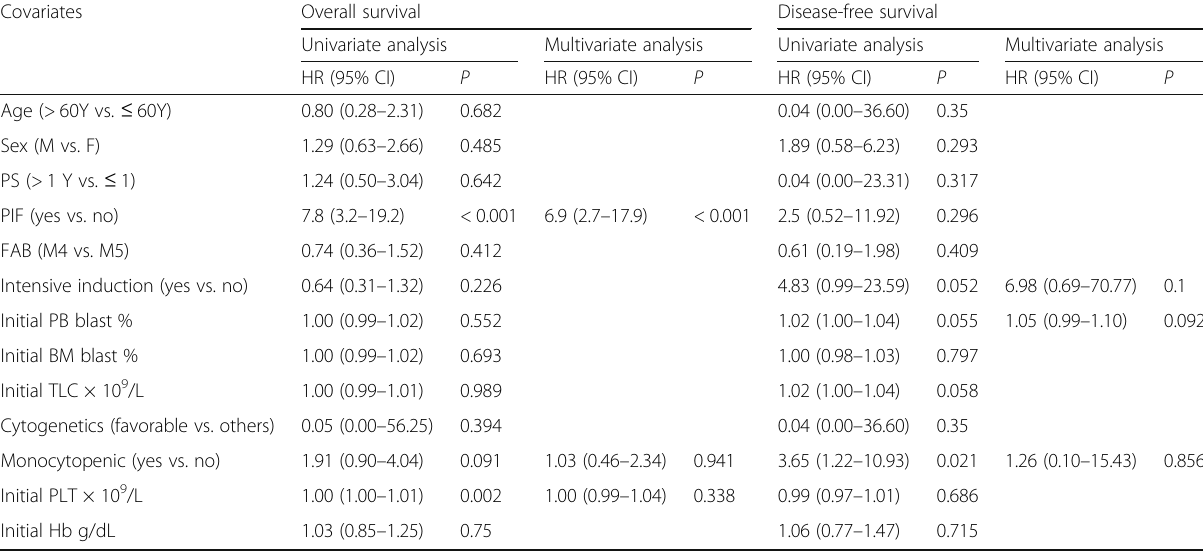
Table 5 Univariate and multivariate Cox-regression analyses for overall and disease-free survival Covariates Overall survival Disease-free survival Univariate analysis Multivariate analysis Univariate analysis Multivariate